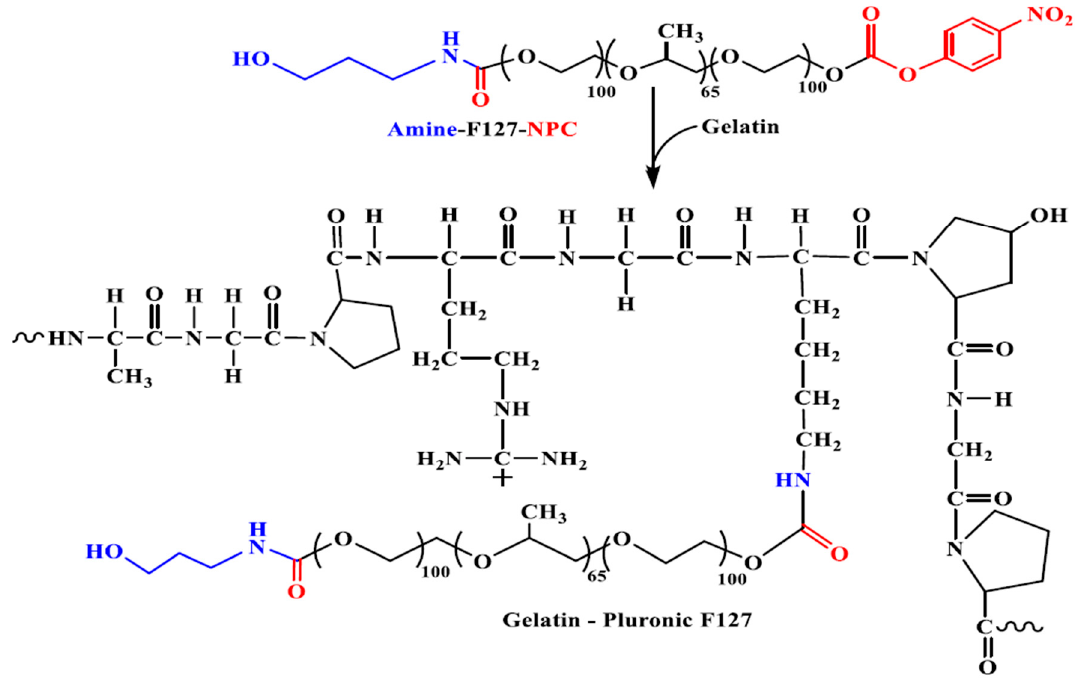
Figure 16. Synthetic scheme of gelatin (Gel)–Pluronic synthesis [161]. A series of poly( L -lactide)-grafted gelatin (Gel-g-PLLA) copolymers were synthesized in order to prepare PTX-loaded micelles by a direct dissolution method